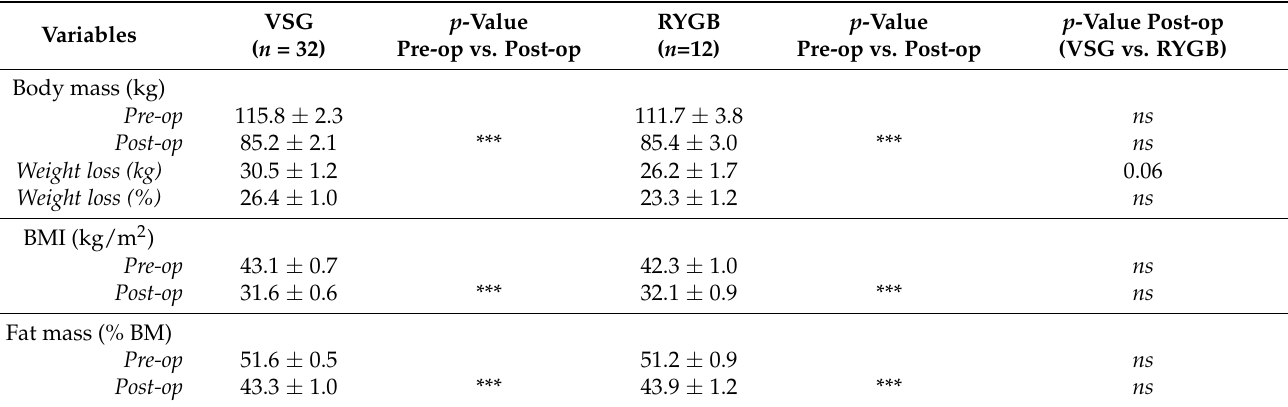
Table 1. Body composition before (pre-op) and 6 months (post-op) after